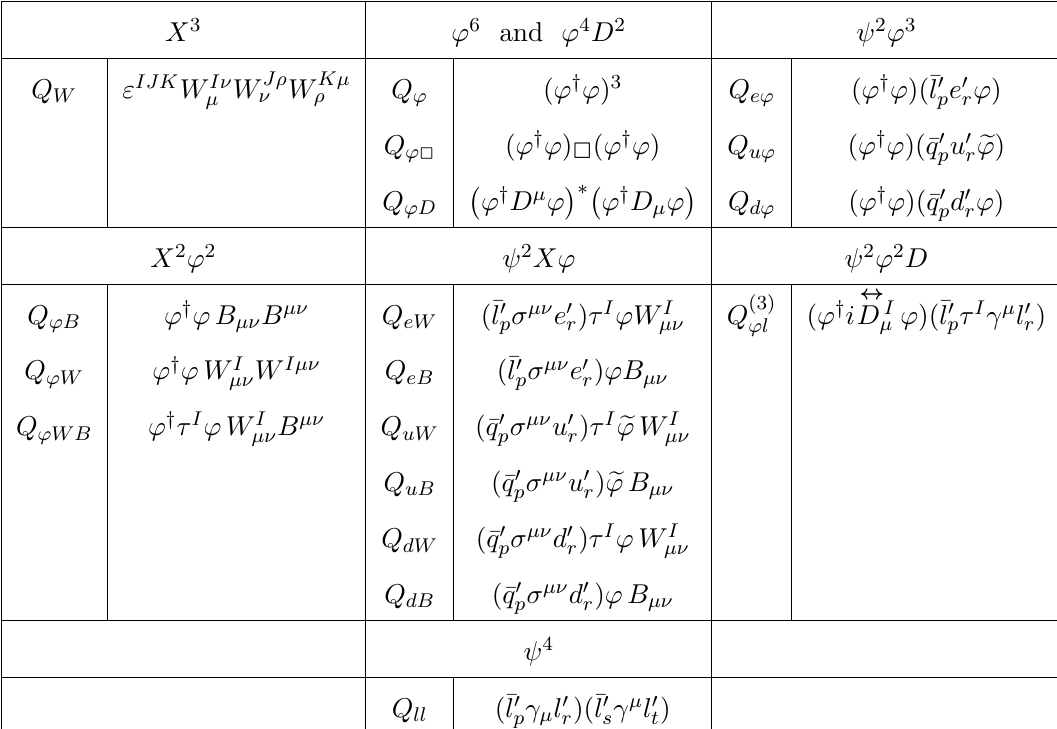
(cid:13)(cid:13) decay amplitude, ! (cid:13)(cid:13) amplitude. The operators Q ll and Q (3) ’l !